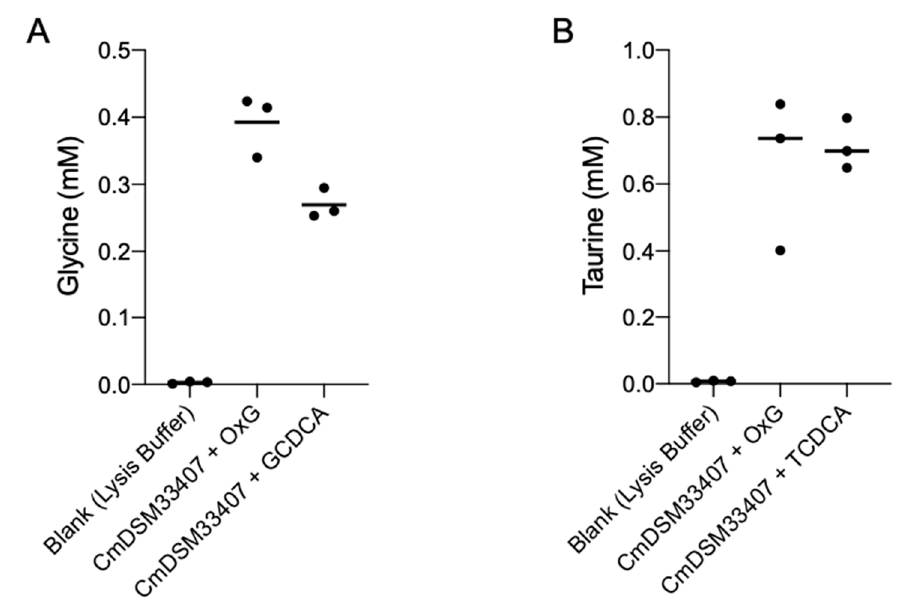
Figure 2. Bile acid deconjugation by Christensenella minuta DSM 33407. ( A ) Quantification of glycine ( B ) and taurine release from OxGall, GCDCA and TCDCA by bacteria cellular lysates of C. minuta DSM 33407 harvested after 72 h of growth. All experiments were performed in triplicates. Key: